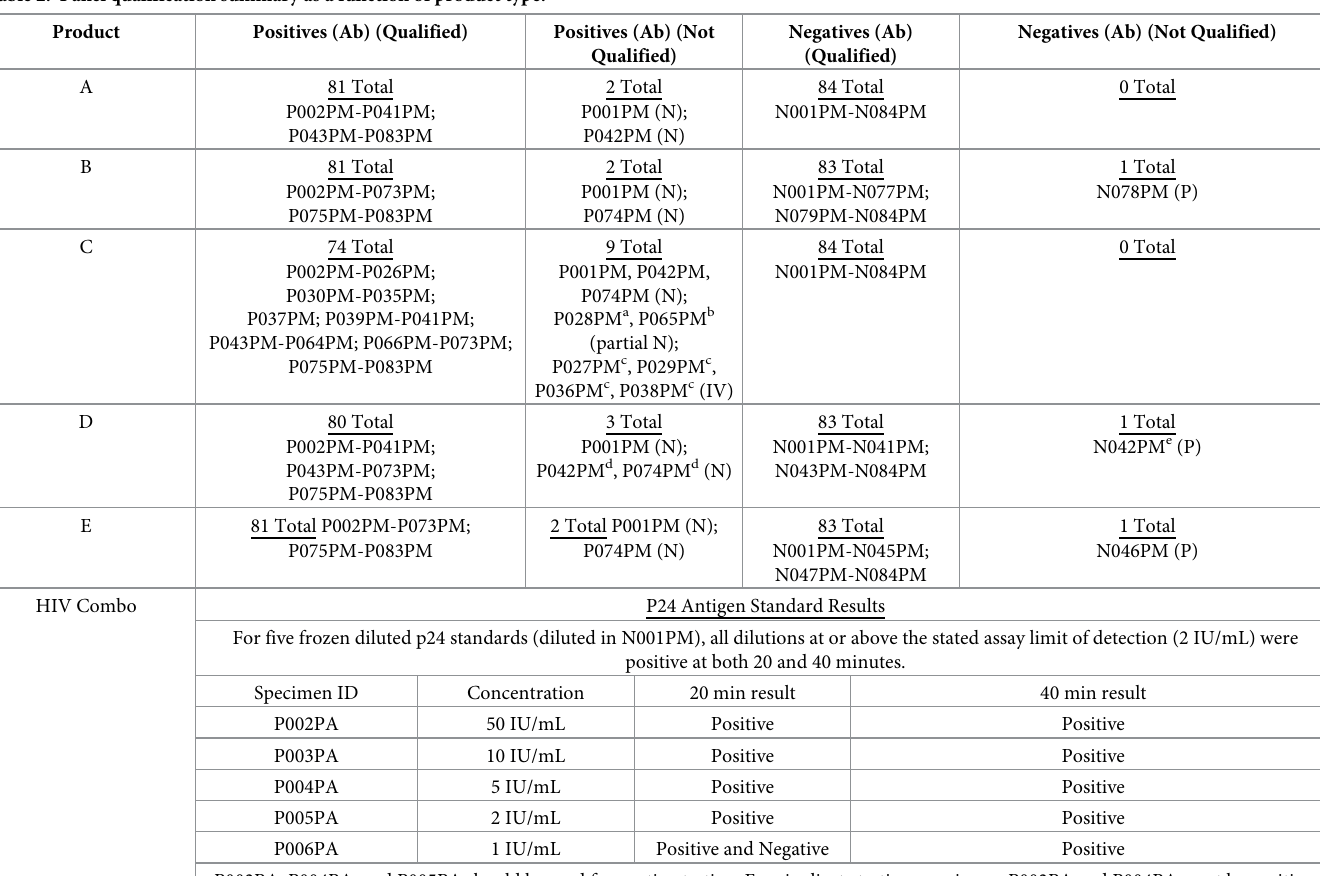
Table 2. Panel qualification summary as a function of product